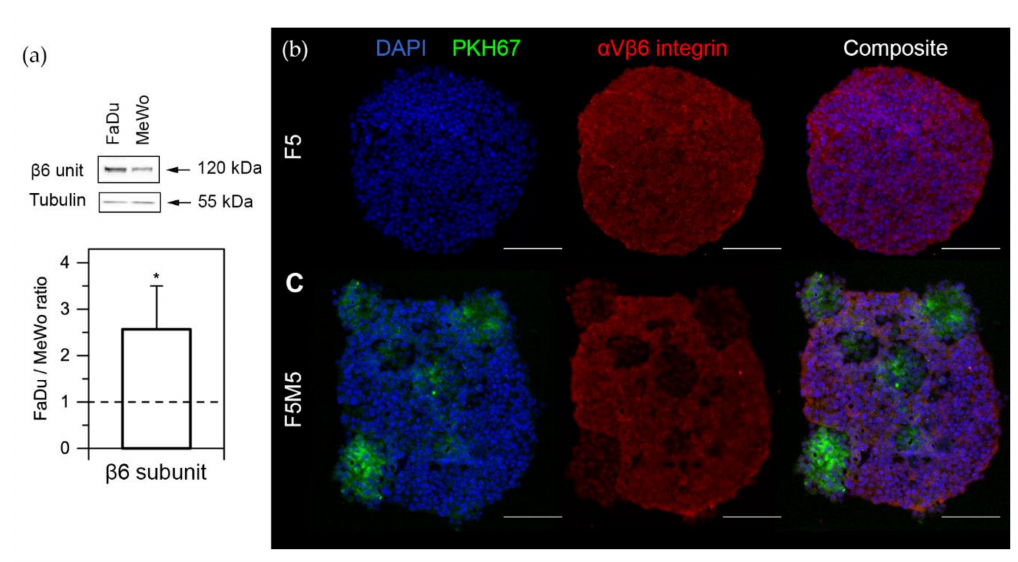
Figure 3. Expression of integrins in FaDu and MeWo cells. ( a ) Western blot of β 6 subunit expression in FaDu and MeWo cells and its quantification analysis. Data represent averages ± SD (n = 5; * p < 0.05, using the one-sample t-test ( µ = 1)). ( b , c ) Typical fluorescence microscopy images of ( b ) F5 and ( c ) F5M5 spheroids cryosections, stained with antibody against α v β 6 integrins and DAPI. MeWo cells were pre-stained with PKH67 green membrane dye. Scale bar—100 µ